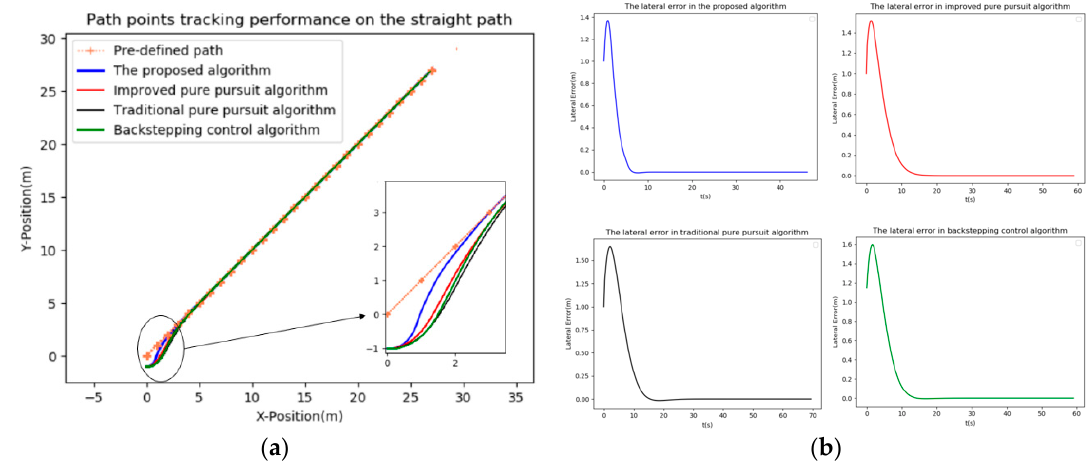
Figure 6. ( a ) Target points tracking performance on the straight path. ( b ) Tracking lateral error of straight path points under four different control schemes.